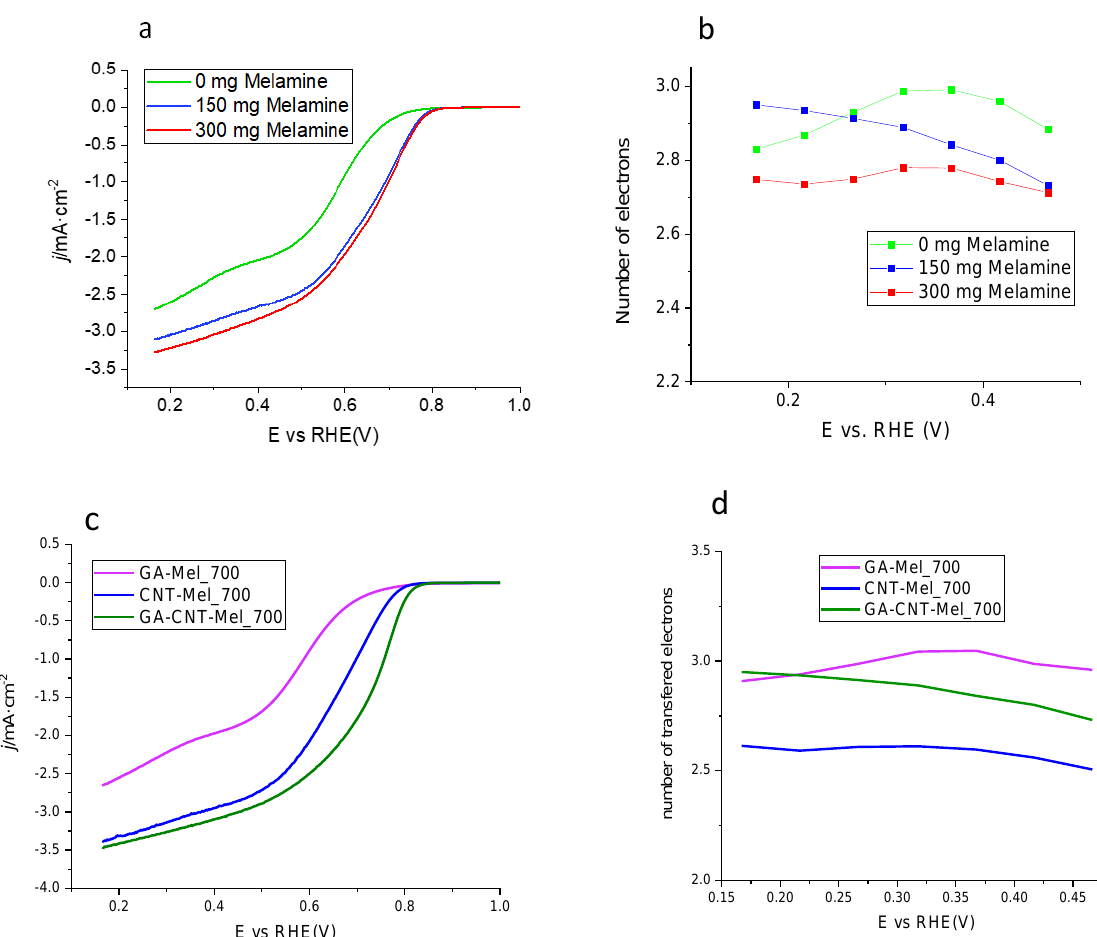
Figure 5. Effect of N-doping using melamine as precursor: ( a ) polarization curves for different amounts of melamine in O 2 saturated 0.10 M KOH solution with a rotating rate of 1600 rpm; ( b ) number of electrons for polarization curves in ( a ); ( c ) polarization curves for N-doping using melamine for graphene aerogel, carbon nanotubes and hybrids thereof; ( d ) and number of electrons transferred for the different supports in ( c